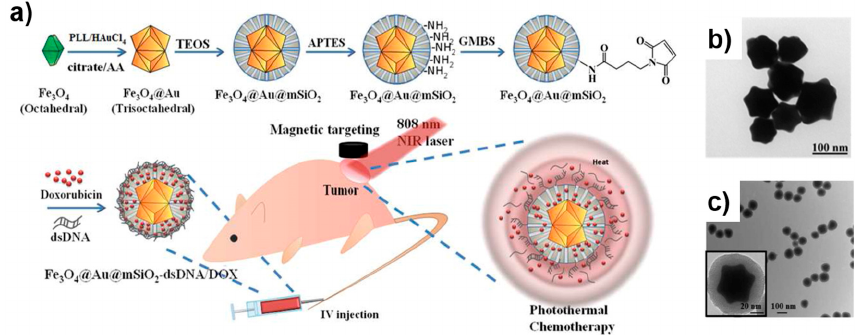
Figure 4. ( a ) Illustration of the preparation of Fe 3 O 4 @ Au @ mSiO 2 -dsDNA/DOX nanoparticles for in vivo treatment of cancer cells, ( b ) TEM image of Fe 3 O 4 @ Au, and ( c ) TEM image of Fe 3 O 4 @Au@mSiO 2